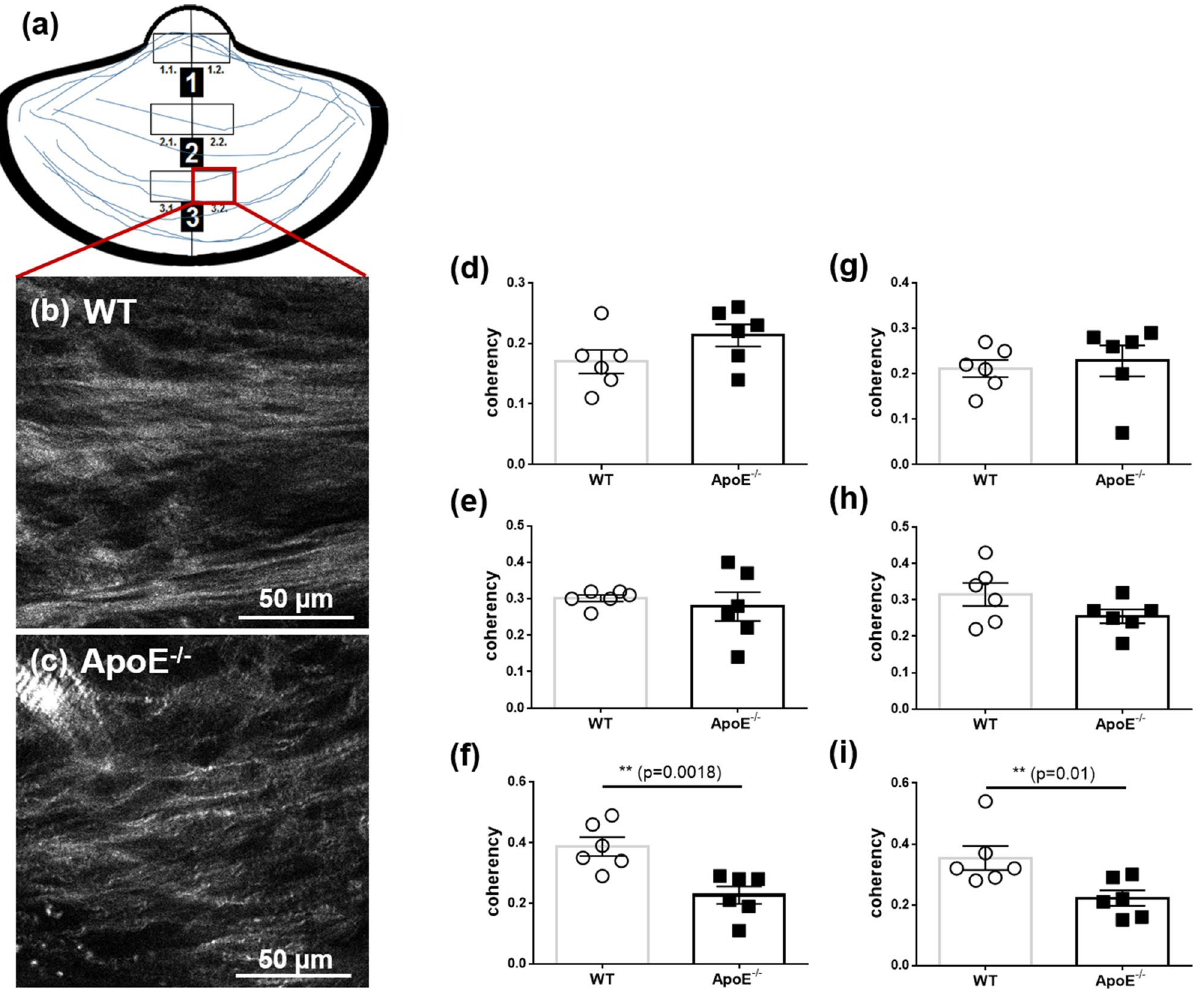
Figure 5. SHG images showing the coherency of collagen fibers. Orientation of collagen fibers (blue) and analyzed subregions within the tip (region1), middle (region 2) and base (region 3) of the aortic leaflet. Representative images from region 3.2. from ( b ) WT mice and ( c ) ApoE −/− mice. The mean coherency of the collagen from ( d ) the region 1.1 ( g ) and the region 1.2, from ( e ) the region 2.1 and ( h ) the region 2.2, from ( f ) in the region 3.1 and ( i ) the region 3.2 from WT mice and ApoE −/−